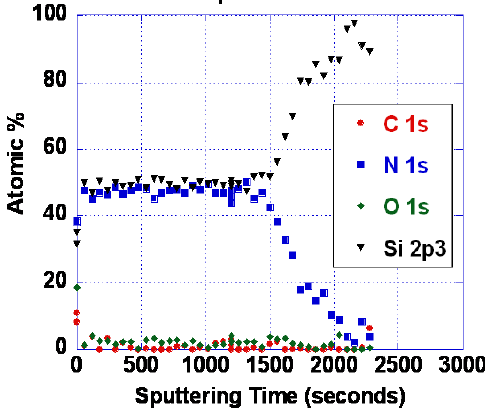
Figure 18. X-ray photoelectron spectroscopy depth profile of silicon oxynitride layer deposited on a Si